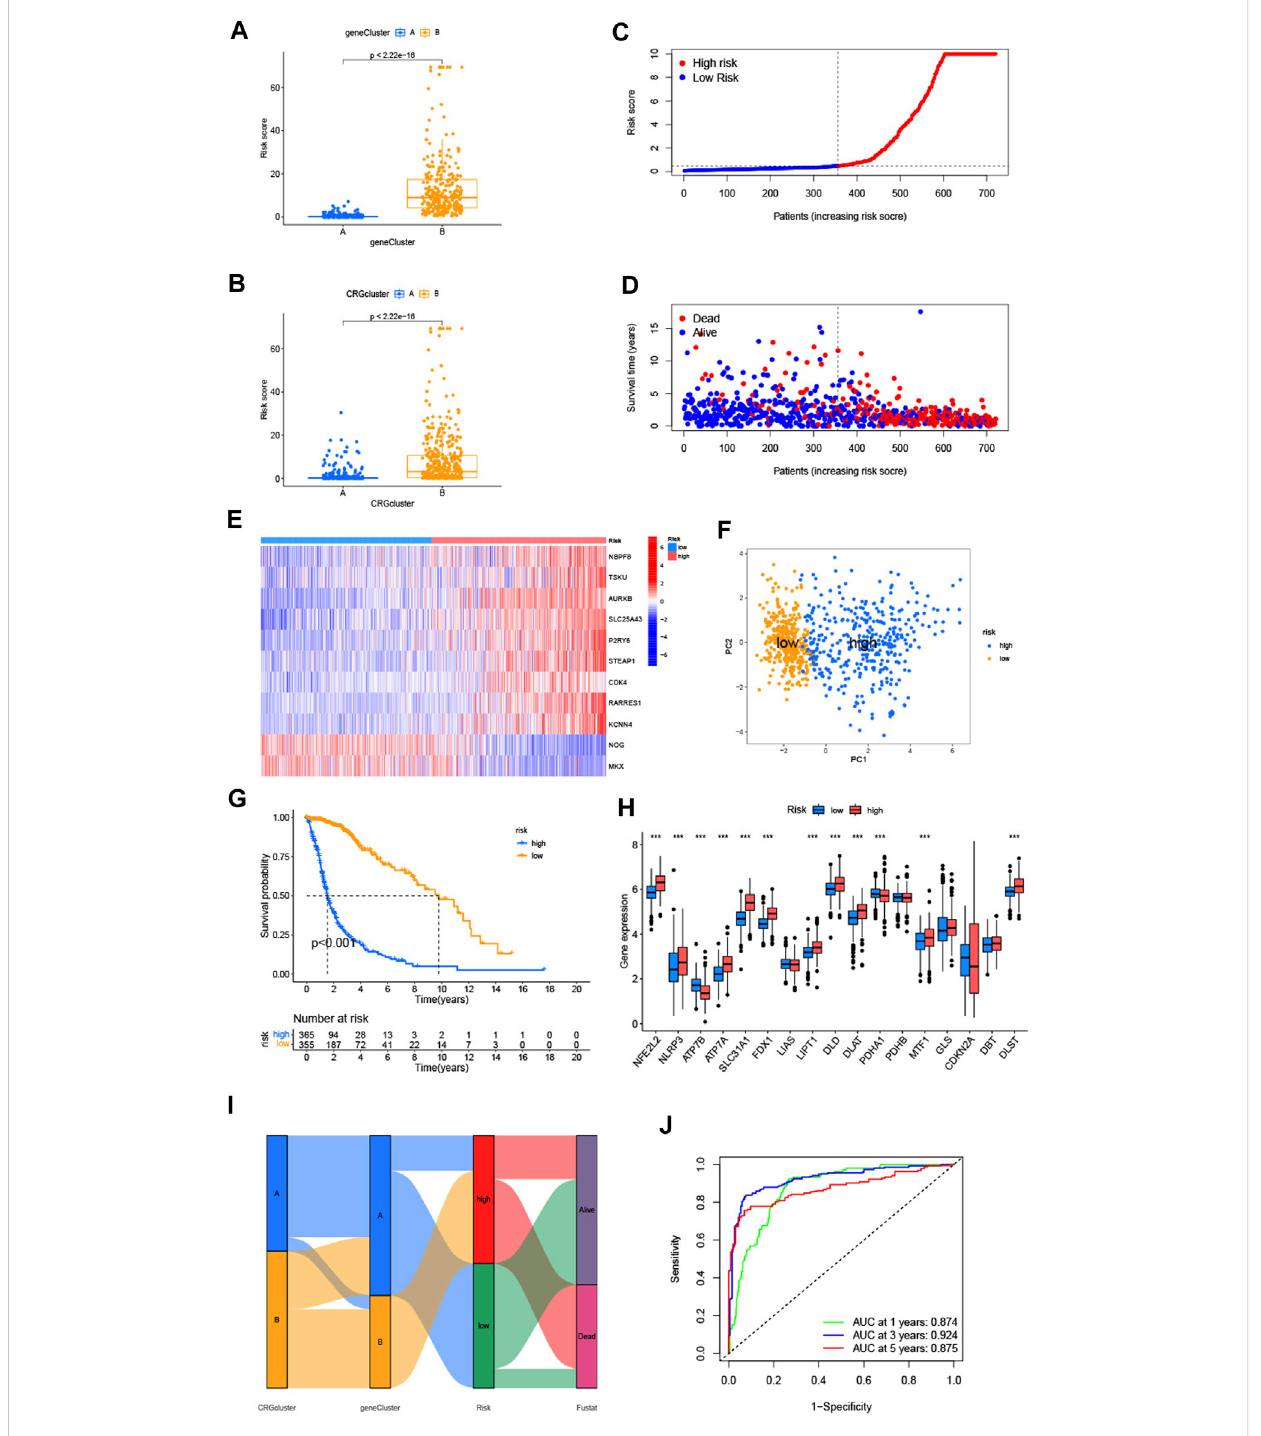
FIGURE 5 (A,B) Differences of CRG-score between 2 cuproptosis-related genes subtypes and gene subtypes. (C,D) Relationships between CRG-score and patients ’ survival status. (E) The heatmap of the CRG-score related genes expressions and CRG-score. (F) The PCA analysis of low-risk and high-risk groups. (G) Kaplan-Meier analysis of low-risk and high-risk groups. (H) Expression of cuproptosis-related genes in low-risk and high-risk groups. (I) The entirety network of the subtypes, risk of CRG-score and survival status based on the corhorts. (J) The ROC curve showed 1-, 3-, and 5-year AUC values. (* p < 0.05; ** p < 0.01; *** p <